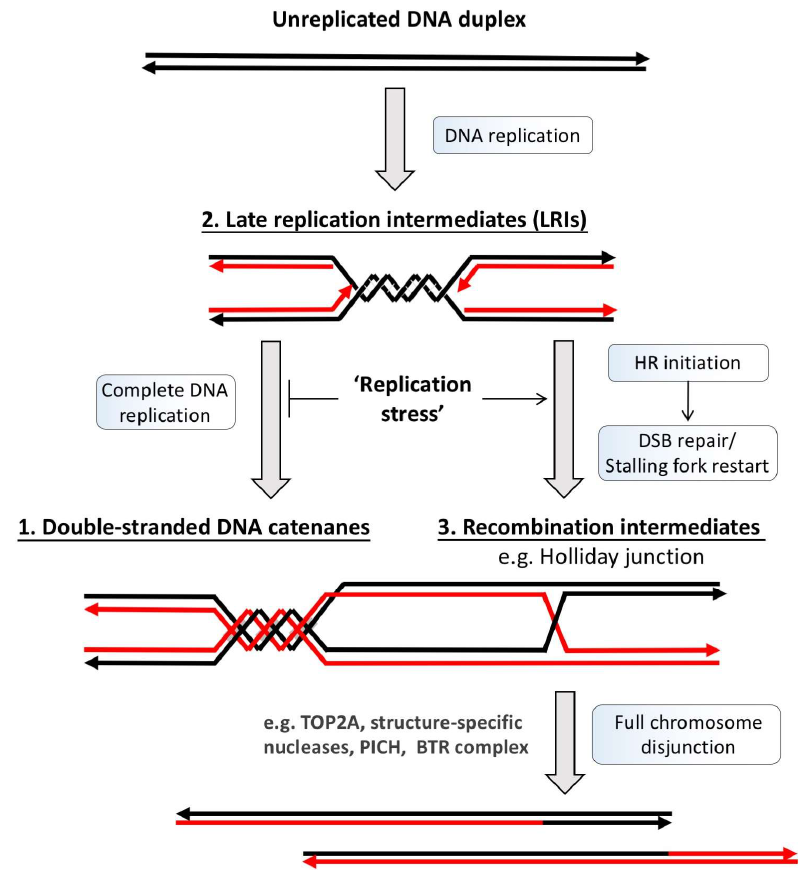
Figure 2. DNA metabolism generates potential DNA linkage structures intertwining sister DNA strands. DNA duplication is achieved through a semiconservative replication process in which the unreplicated DNA duplex template (black lines) is first separated, followed by the generation of two new DNA strands by DNA polymerases (red lines). Due to the helical intertwining nature of the DNA duplex, its unwinding produces supercoiling, which is subsequently converted into double-stranded DNA catenation after replication (1). However, if the completion or termination of DNA replication fails, such as under replication stress conditions, the under-replicated DNA regions can also intertwine sister chromatids. These regions usually arise at late replication sites and manifests as double stalled forks or replication intermediates (2). On the other hand, the rescue of the stalled or damaged replication forks by homologous recombination (HR) reactions can also lead to sister chromatid intertwinements via the generation of HR intermediates, such as D-loop and Holliday junctions (3). Prior to or during mitosis, cells have to resolve all of these topological and covalent DNA linkages to allow faithful sister chromatid disjunction to proceed. BTR: Bloom helicase/Topoisomerase III α /RecQ-mediated genome instability protein complex 1 and 2; DSB: Double-stranded break; TOP2A: topoisomerase II α ; PICH: Plk1 -interacting checkpoint helicase.